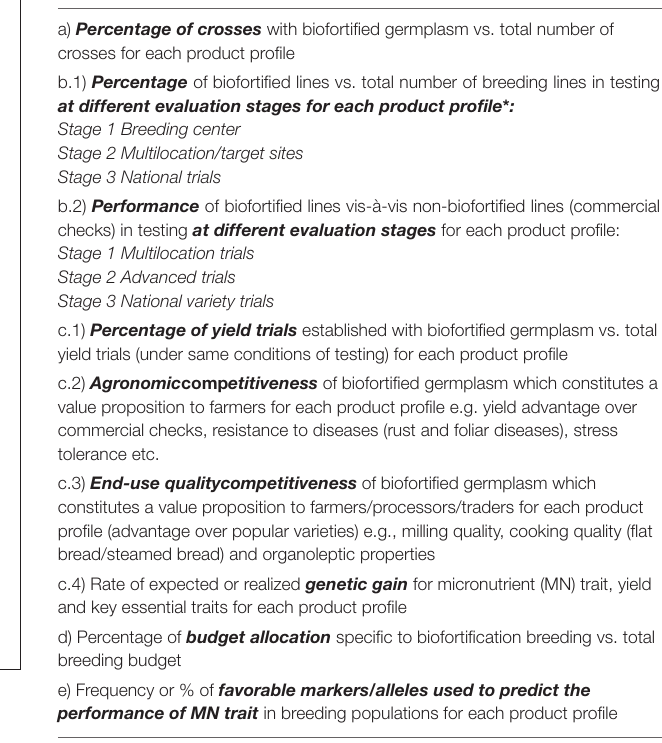
and hybrid parents (including the released biofortified varieties) in gene banks at CG centers.